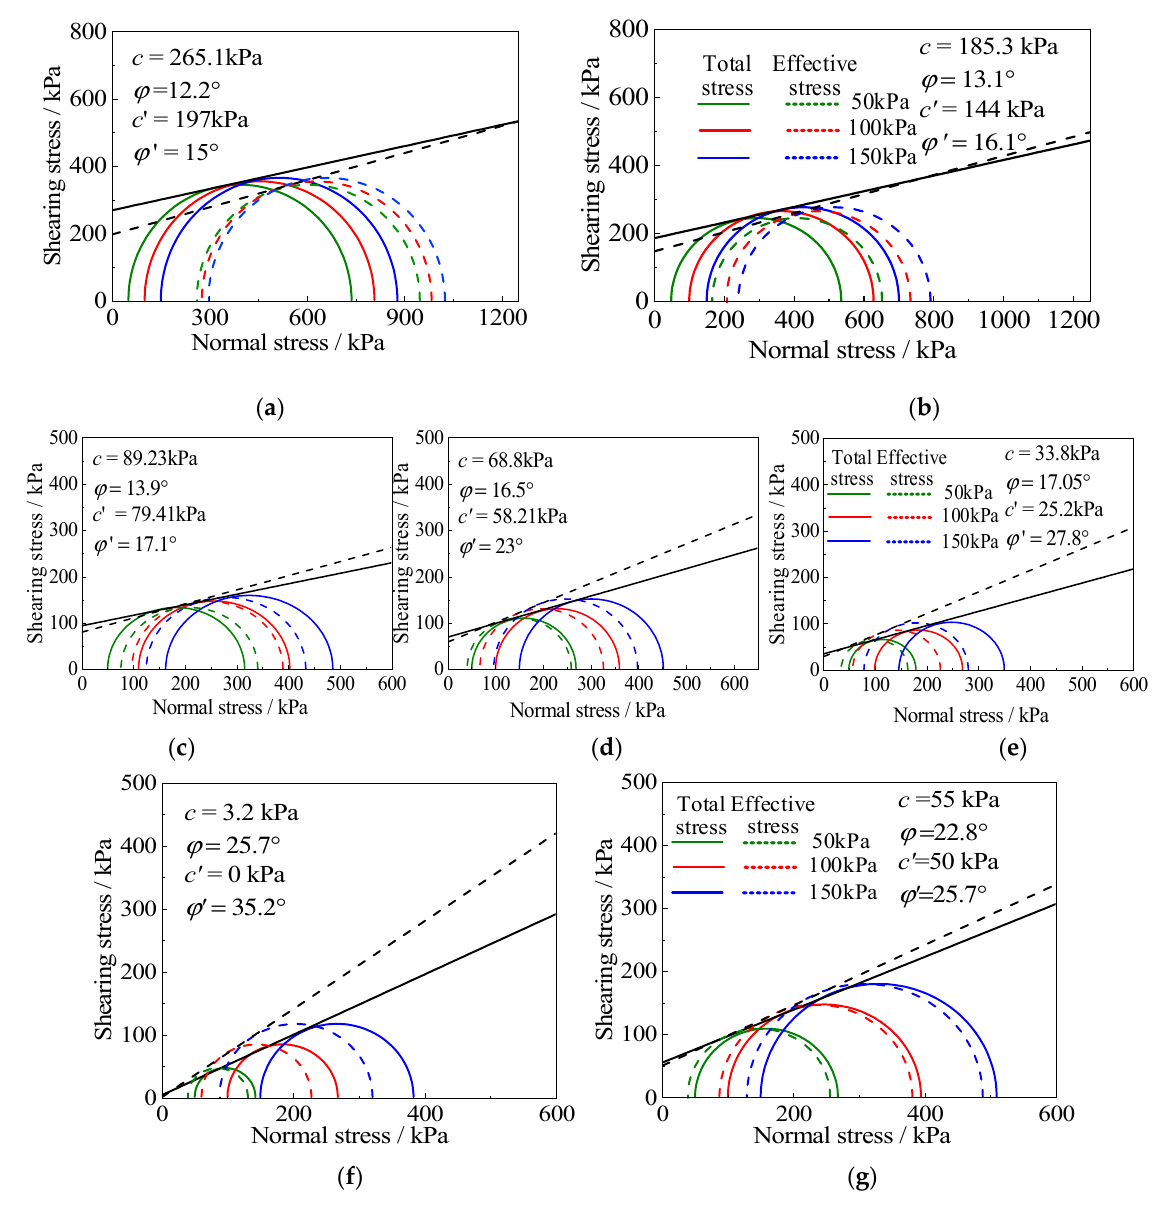
Figure 14. Mohr’s circle and the corresponding shear strength envelope. ( a ) X = 10%, C = 3.5 g/100 mL, ( b ) X = 20%, C = 3.5 g/100 mL, ( c ) X = 30%, C = 3.5 g/100 mL, ( d ) X = 40%, C = 3.5 g/100 mL, ( e ) X = 50%, C = 3.5g/100 mL, ( f ) X = 20%, C = 0 g/100 mL, ( g ) X = 20%,C = 2.5g/100 mL.